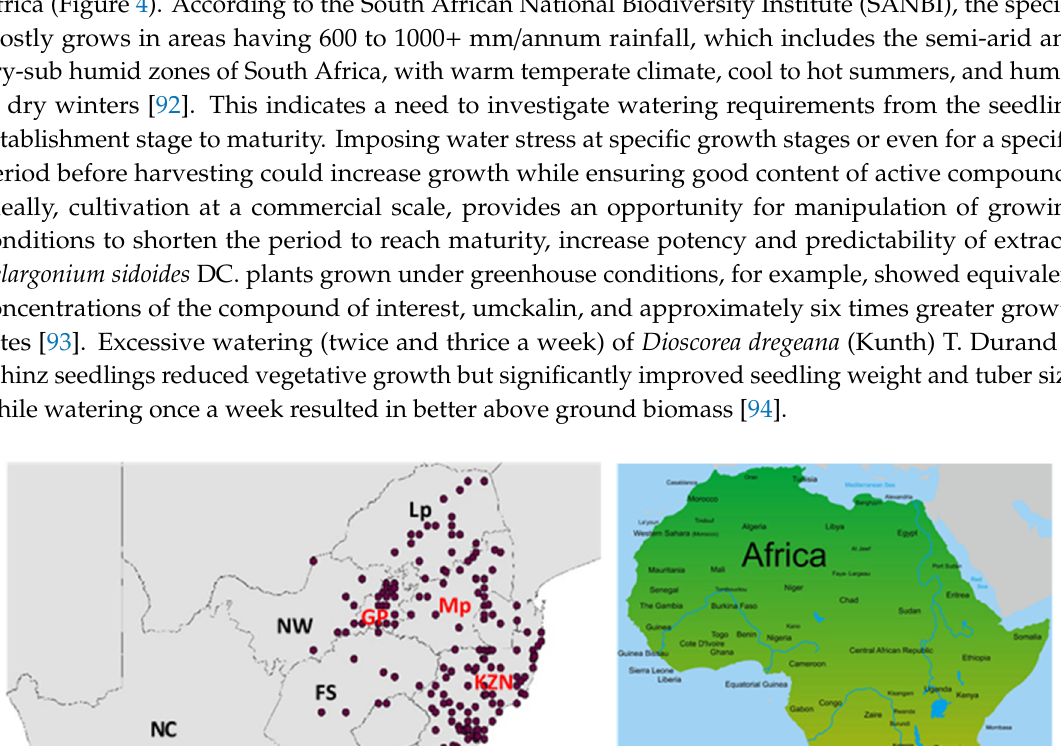
Figure 5. A potential pest and its potential damage on Hypoxis hemerocallidea plants. ( A ) African bollworm ( Helicoverpa armigera ) feeding on the leaves and ( B ) on the seed pods (Source: Agricultural Research Council-Vegetable and Ornamental Plant Research Station). Other important aspects of commercial cultivation of H. hemerocallidea include optimum size and timing before harvesting the species, as it is not clear at what age or size are the medicinally active compounds available or optimum in the corm. In general, the target compounds in medicinal plants are secondary metabolites which serve as an adaptation strategy to environmental stress, infection,